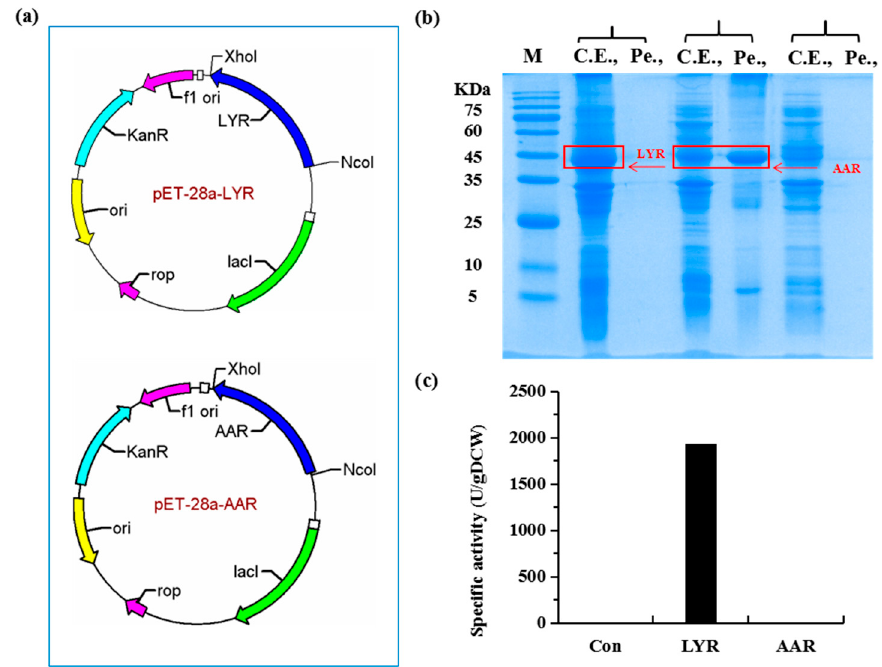
Figure 2. Comparison of specific activities of the whole cell BL21 ‐ LYR and BL21 ‐ AAR. ( a ) The racemases from Proteus mirabilis BCRC10725 (lysine racemase, LYR) and Lactobacillus casei (amino acid racemase, AAR) were cloned into plasmid pET ‐ 28a to generate plasmid pET ‐ 28a ‐ LYR and pET ‐ 28a ‐ AAR and transformed into E. coli BL21 (DE3) respectively; ( b ) Sodium dodecyl sulfate ‐ polyacrylamide gel electrophoresis (SDS ‐ PAGE) of cell extracts of E. coli BL21 ‐ LYR and BL21 ‐ AAR grown in Luria–Bertani (LB) medium at 30 °C. Equal amounts (20 μ g) of protein were applied to each lane. Vertical lanes are labeled by M (protein size marker), C.E. (crude extract), or Pe. (pellet); ( c ) The specific activities of the whole cell BL21 ‐ LYR and BL21 ‐ AAR.